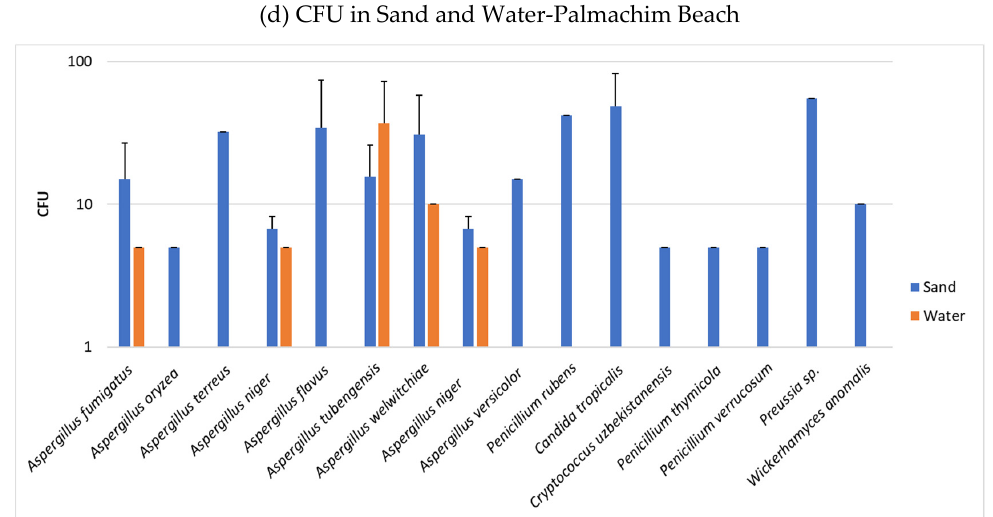
Figure 4. Fungal load in sand and water. Axis Y is CFU per gr for sand and CFU per ml for water. The error bars are S.D.